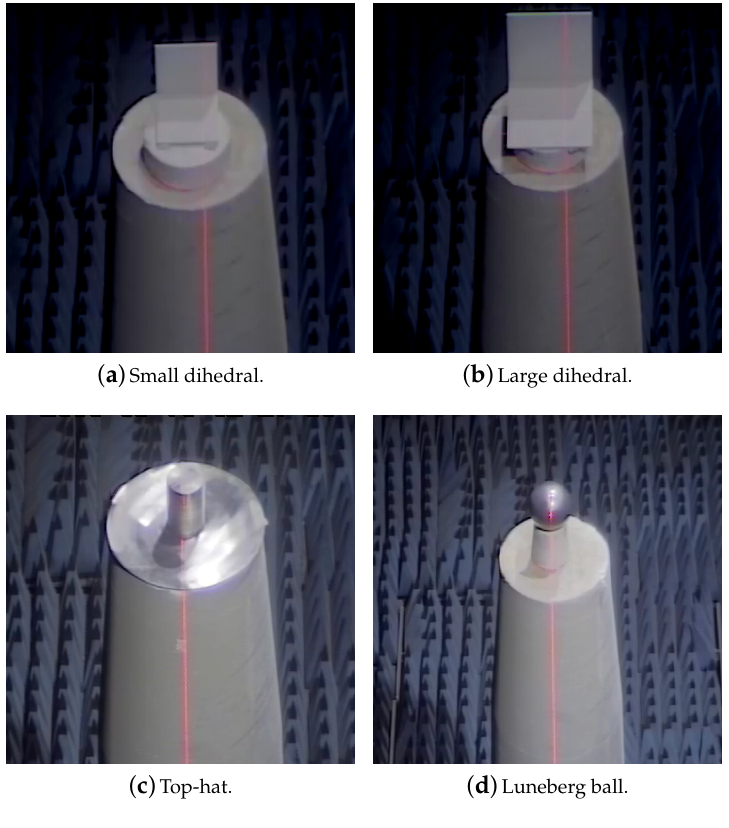
Figure 1. Optical images of targets. ( a ) Small dihedral. ( b ) Large dihedral. ( c ) Top-hat. ( d ) Luneberg ball. Table 1. Parameters of the X-band chamber circular SAR